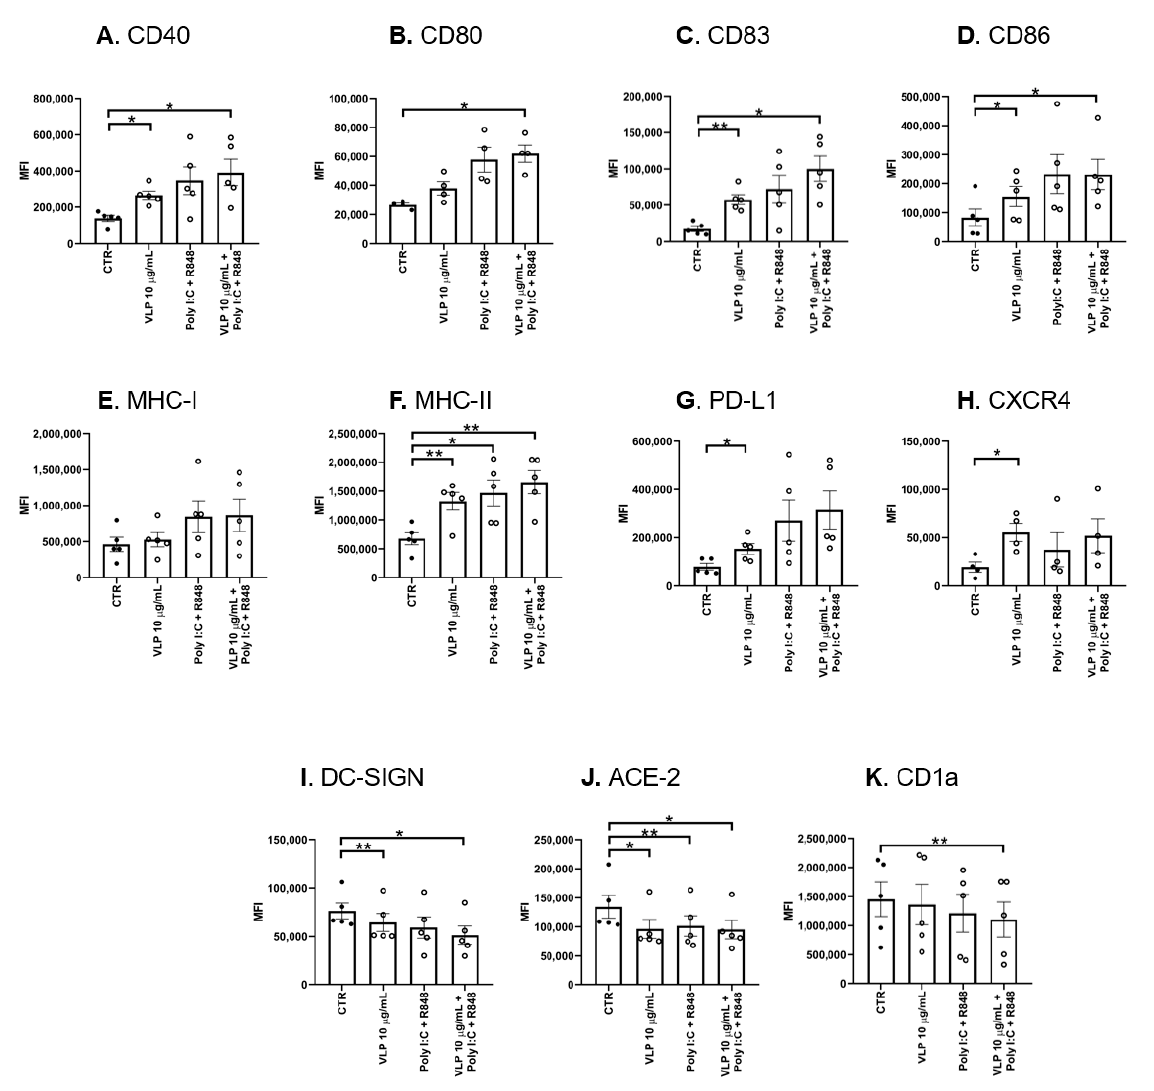
Figure 1. VLPs induce changes in DCs. DCs were treated with 20 µg/mL Poly I:C and 2.5 µg/mL R848, or 10 µ g/mL VLPs, or VLPs plus 20 µ g/mL Poly I:C and 2.5 µ g/mL for 24 h. The expression of R848, or 10 µg/mL VLPs, or VLPs plus 20 µg/mL Poly I:C and 2.5 µg/mL for 24 h. The expression of